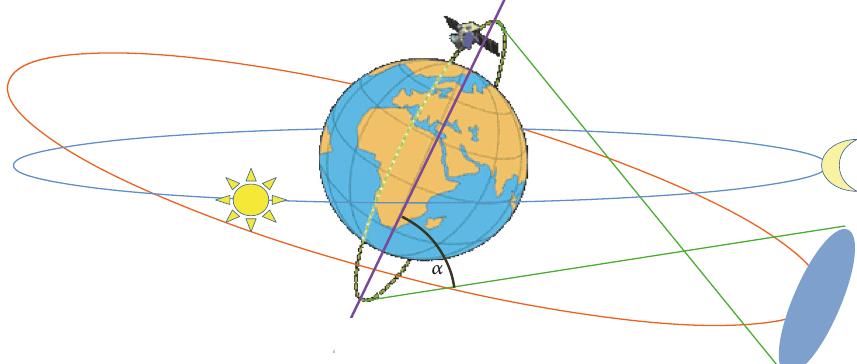
Figure 1: Pointing direction of the deep space view (green) compared to the celestial equator (red) and the ecliptic (blue). The slight tilt of the Moon’s orbit against the ecliptic and of the orbital axis of the weather satellite against the equator is not shown for the sake of simplicity. The DSV points some 75 ∘ away from nadir—angle 𝛼 in (3)—and describes a circle in the sky during an orbit of the satellite. When the Moon touches this circle, it appears in the DSV